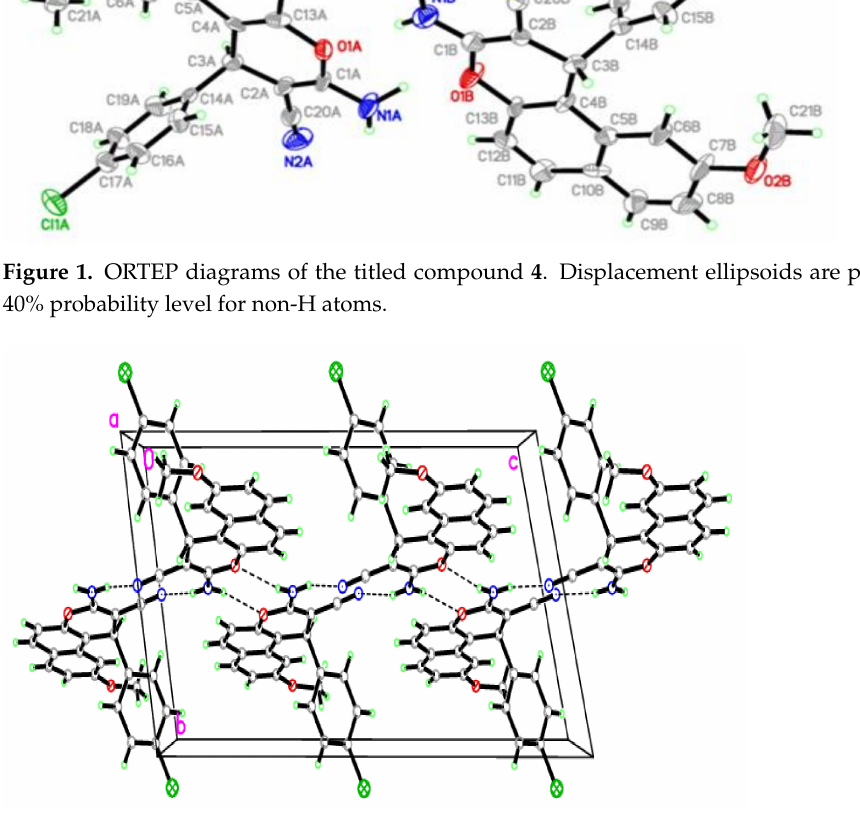
Figure 2. Molecular packing of compound 4 . Hydrogen bonds are drawn as dashed